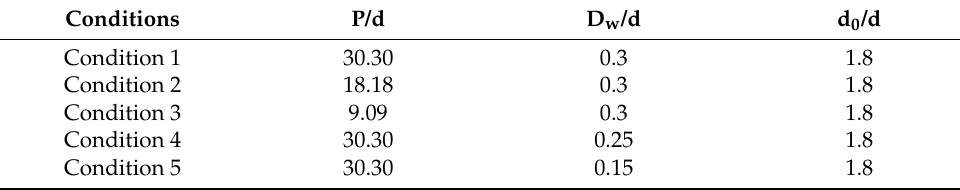
Table 11. Working conditions of the numerical simulation of Chen et al.